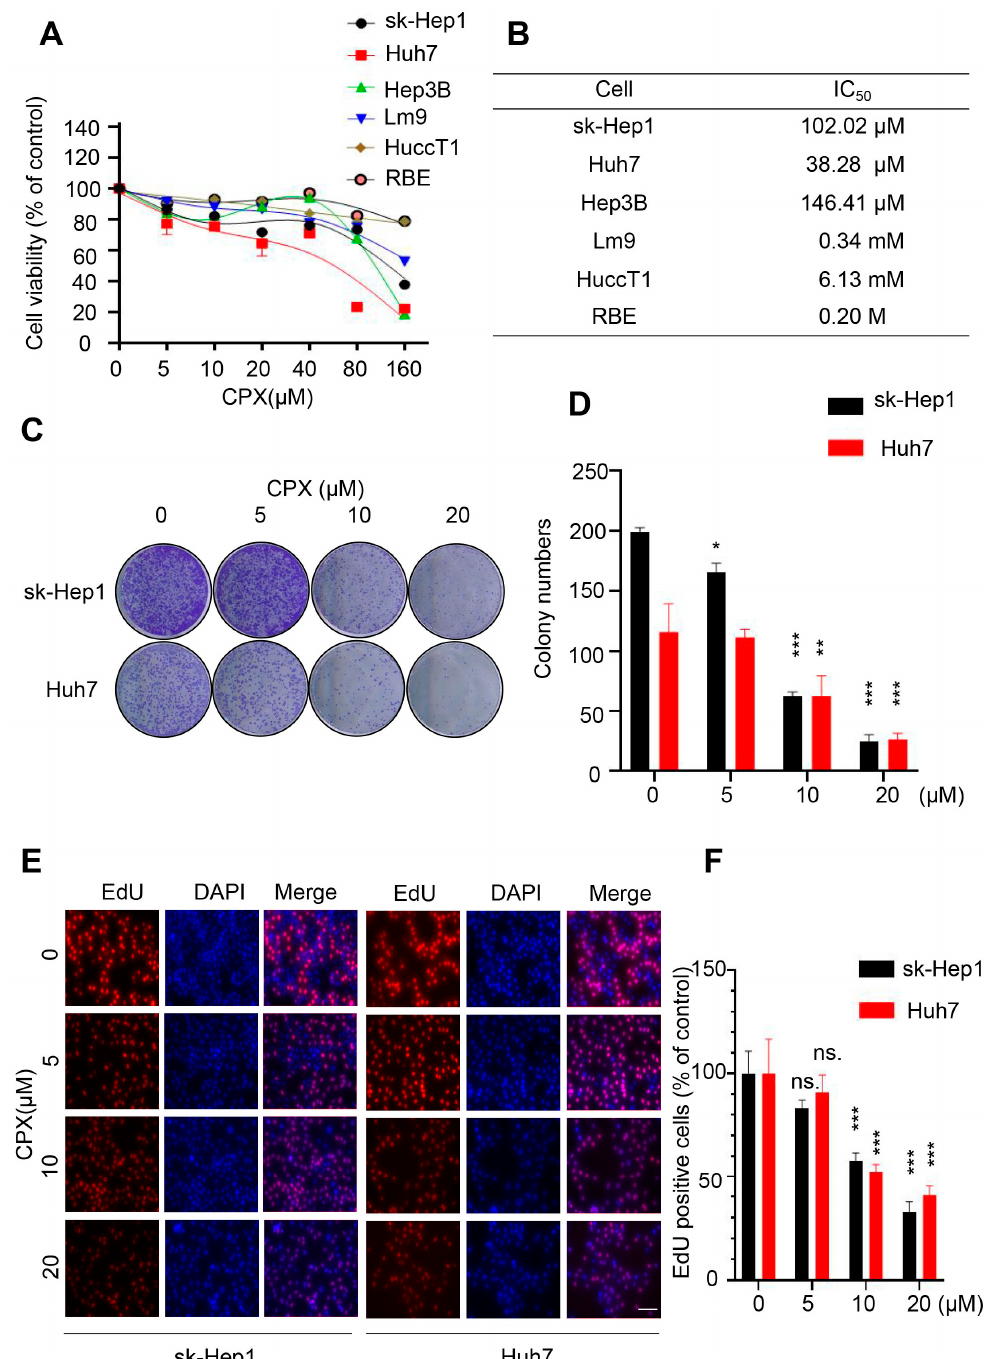
Figure 1. CPX inhibits proliferation in HCC cells. ( A ) The cell viability was determined by CCK8 assays. sk-Hep1, Huh7, Hep3B, HuccT1, RBE and Lm9 cells were treated with the indicated concen- trations of CPX for 24 h. ( B )The IC50 value of different cells treated with the indicated concentrations of CPX for 24 h. ( C , D ) Clone formation was performed to assess the cell proliferation rate. sk-Hep1 and Huh7 cells were treated with the indicated concentrations of CPX for 24 h; then, cells were inoculated into 12-well plates for two weeks and colony numbers were quantified. ( E , F ) EdU assay of HCC cells subjected to the indicated concentrations of CPX for 24 h. The EdU positive cell rate was quantitated. Scale bar, 100 μ m. Data are means ± s.d. and are representative of 3 independent experiments. *, p < 0.05, **, p < 0.01, ***, p < 0.001. Statistical significance compared with respective control groups.